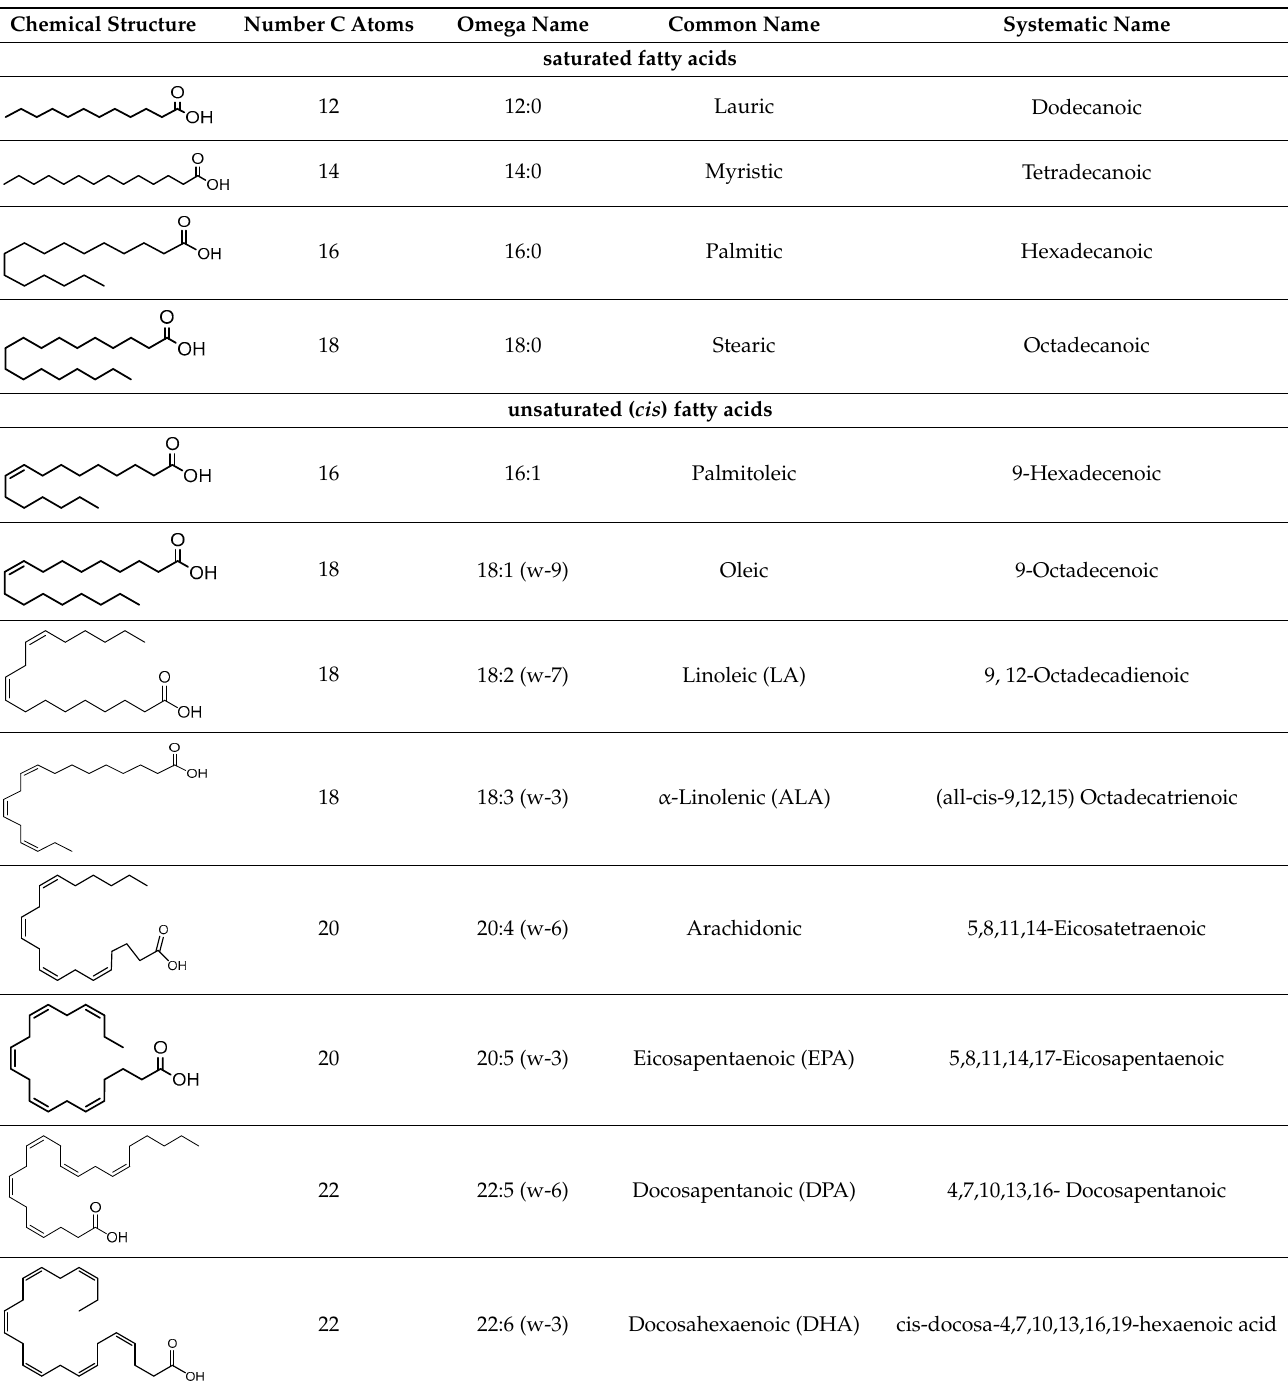
Table 1. Chemical structures and common names of some fatty acids.